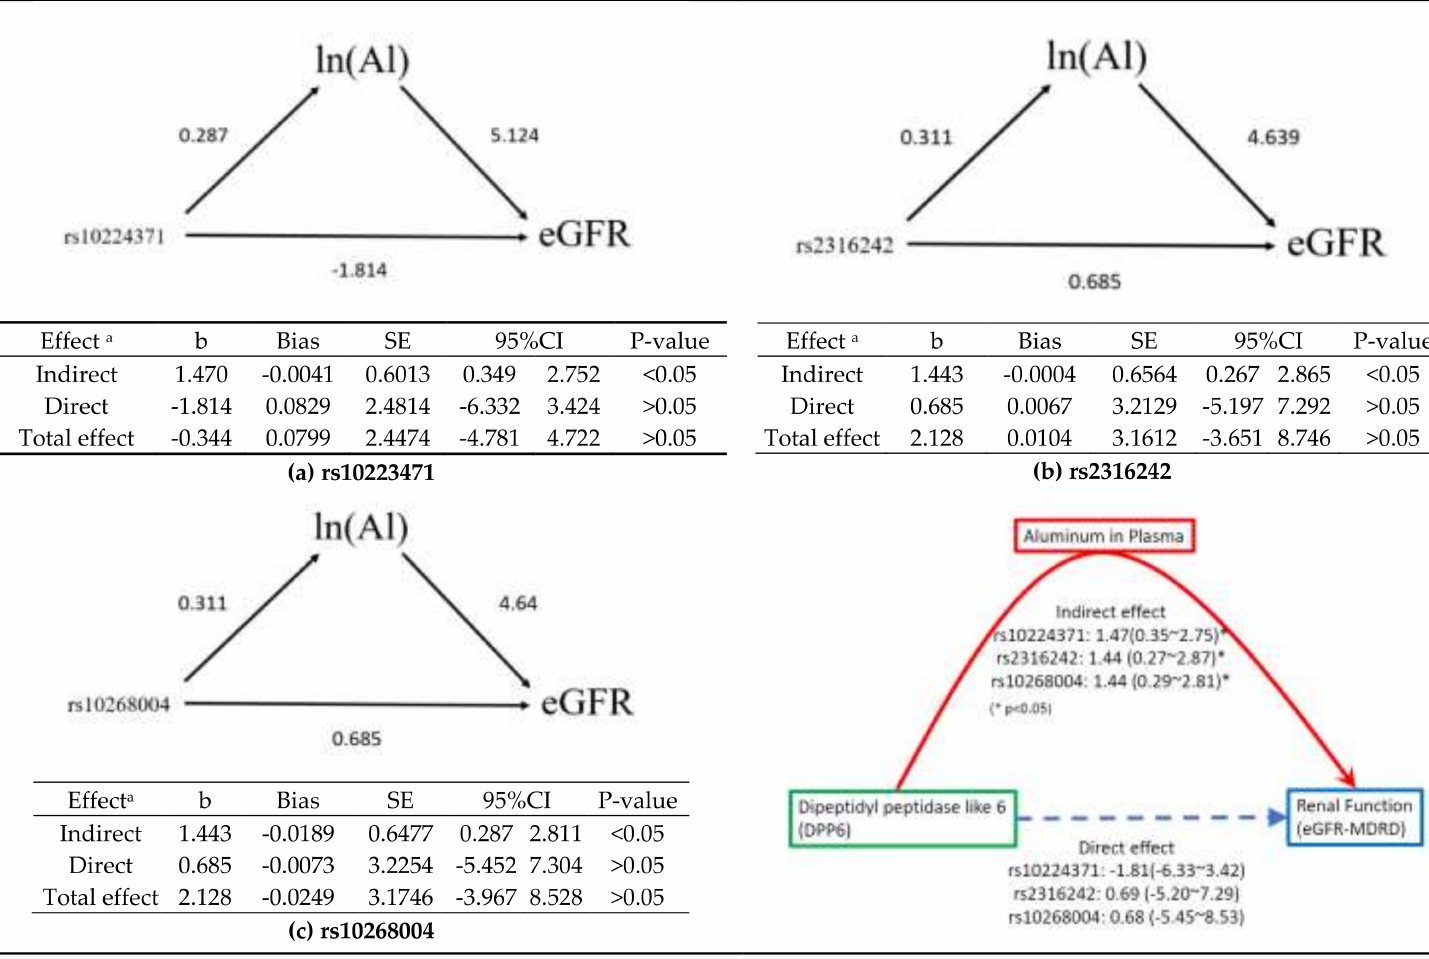
Figure 5. The mediation analysis of 3 SNPs within DPP6, ln (aluminum) levels in plasma, and eGFR. ( a ): rs10224371 was fitted as an additive model effect with 0, 1, and 2 for CC, CT, and TT. ( b ): rs2316242 was fitted as an additive model effect with 0, 1, and 2 for CC, CT, and TT. ( c ): rs10268004 was fitted as an additive model effect with 0, 1, and 2 for TT, GT, and GG. (a): each effect with adjusted gender, age, smoke experience, and drinking habits. ( b ): coefficient; SE, standard error; 95%CI, 95% confidence interval estimated by percentile bootstrap methods. A summary is shown in the right lower quadrant. * p <